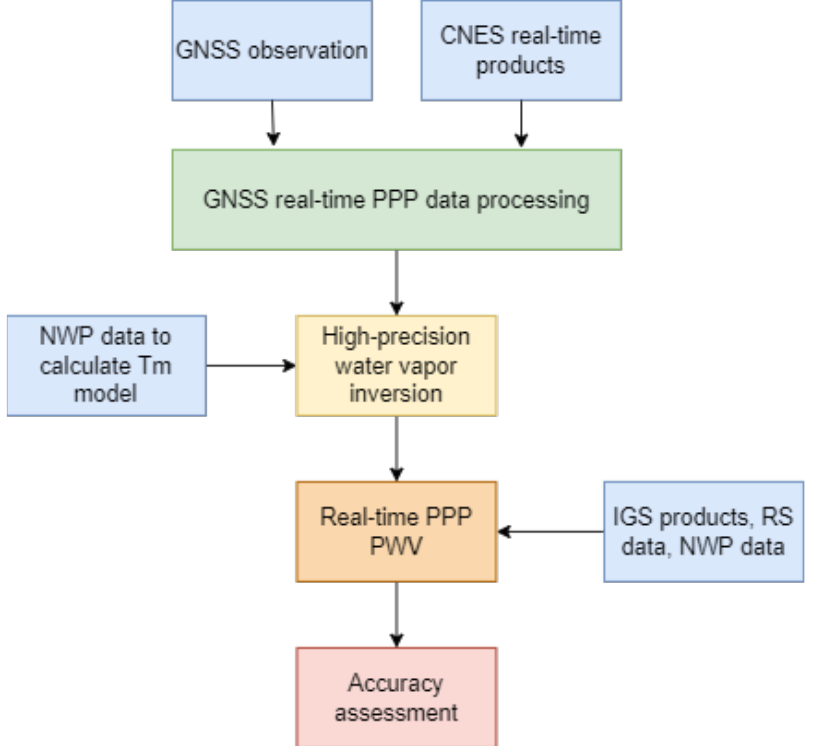
Figure 1. GNSS station real-time atmospheric water vapor inversion process.